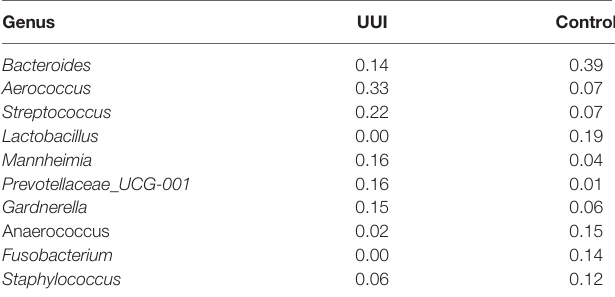
TABLE 4 | Betweenness centrality measured of key bacteria in the vaginal microbiome network (de fi ned by bacteria with a betweenness score >0.10).